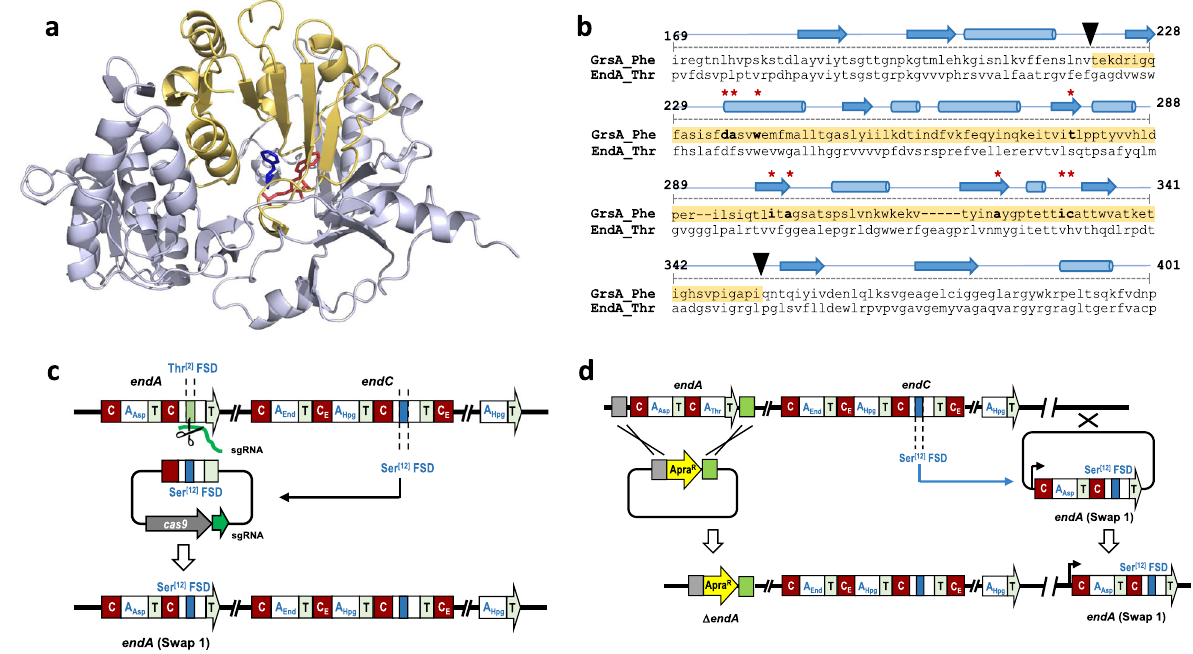
Fig. 2 Subdomain swap strategies. a The structure of a ligand-bound GrsA Phe-A domain (PDB: 1AMU) 32 . The fl avodoxin-like subdomain (FSD) is highlighted in yellow and ligands phenylalanine and adenosine monophosphate (AMP) are shown in blue and red, respectively. Residues HKGISNLKVFFENSLNV which form an alpha helix have been removed for greater visibility of the ligands. b Alignment of the grsA Phe-A domain with the endA Thr [2] -A domain, with the secondary structural features indicated and nine of the ten amino acid substrate binding residues (except Lys517) marked with red asterisks 20 . The FSD sequence is highlighted in yellow and the black triangles show cut sites for the subdomain swap. c Single-step CRISPR- Cas9 strategy for exchanging subdomains at the native locus. sgRNA-guided Cas9 cleaves within the Thr [2] A domain of endA . DNA repair utilizes a plasmid-borne sequence containing endA possessing a Thr [2] to Ser [12] subdomain swap, resulting in seamless exchange of the Thr [2] FSD with a Ser [12] FSD at its native locus within the BGC. d Schematic for conventional multi step gene knockout and complementation strategy. The wild type endA is replaced with an apramycin resistance cassette. The resultant Δ endA strain is complemented with an integrative plasmid containing endA (Swap 1) where the subdomain sequence of the Thr [2] A domain is replaced with the subdomain from the Ser [12] A domain. Insertion of endA (Swap 1) occurs at the Φ C31 site outside of the enduracidin biosynthetic gene cluster